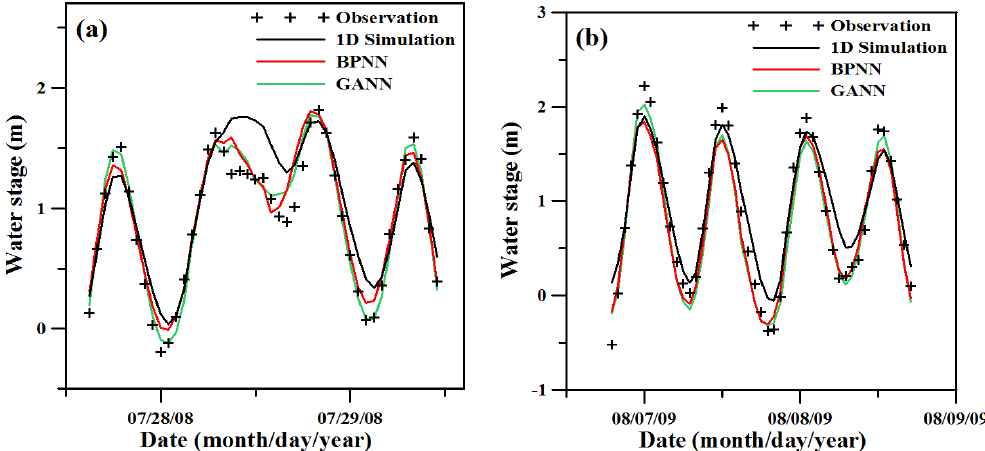
Figure 8. A comparison of observed and simulated water stages for the flood routing hydrodynamic model, BPNN and GANN model verification at the Taipei Bridge station